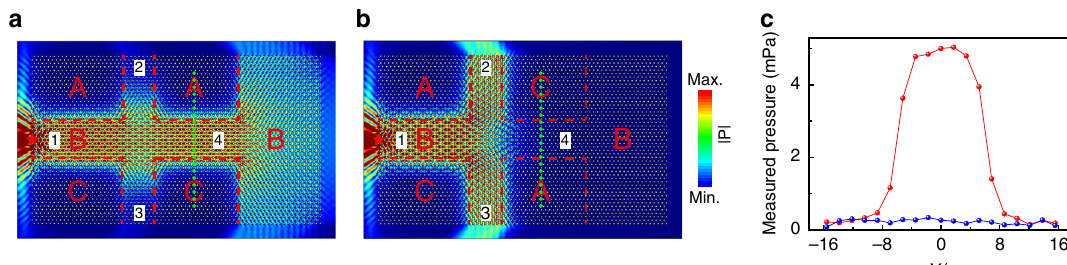
Fig. 3 Splitting of TVWSs. a , b Simulated acoustic pressure fi eld distributions under point excitation on the left side for two different con fi gurations at 5.55 kHz. Four input/output ports labeled 1, 2, 3, and 4 are located in domain B. c The red and blue dots are the measured pressure pro fi les along the green dotted lines in a and b ,